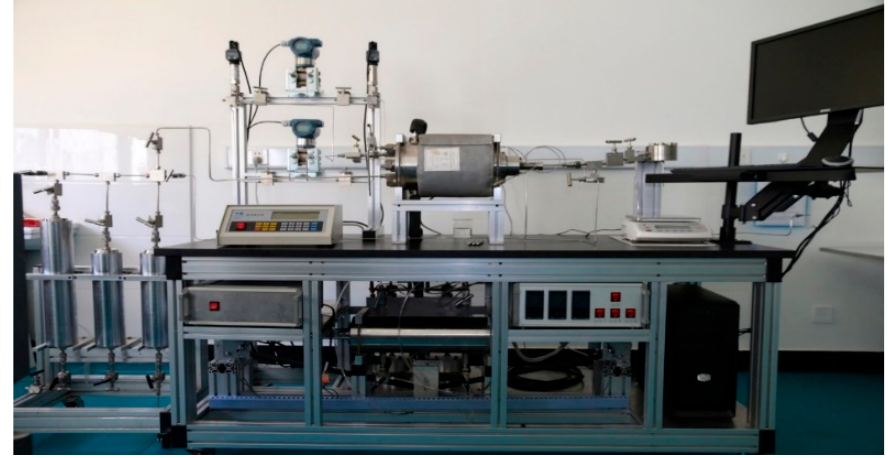
Figure 2. Multi-functional core flow system. Table 2. Base fluid viscosity test at different temperatures.